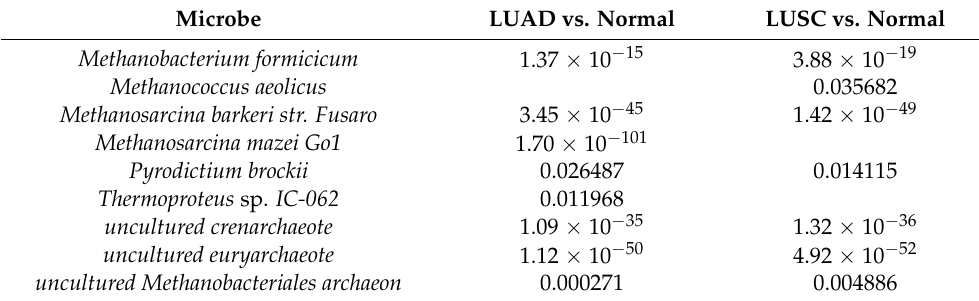
Table 1. List of microbes differentially abundant across LUAD and normal samples and LUSC and normal samples. Corresponding p -Value denoting significance of